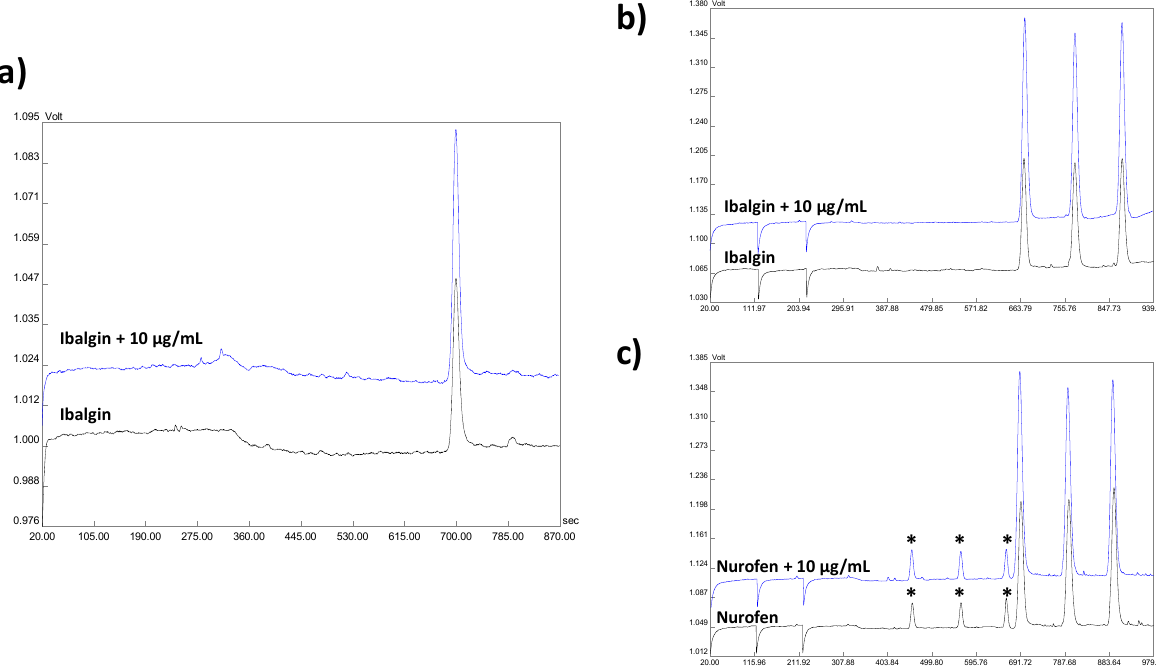
Figure 2. Illustrative electropherograms obtained from the selectivity and recovery tests in phar- maceutical matrices. ( a ) Analysis of drug sample (Ibalgin tablets) and fortified drug sample with the ibuprofen standard at a 10 µ g/mL concentration level performed with the conventional single sample injection. ( b ) Analysis of drug sample (Ibalgin tablets) and fortified drug sample with the ibuprofen standard at a 10 µ g/mL concentration level performed with the repeated sample injection. ( c ) Analysis of drug sample (Nurofen oral suspension) and fortified drug sample with the ibuprofen standard at a 10 µ g/mL concentration level performed with the repeated sample injection. *—an unidentified component present in the oral suspension sample matrix.